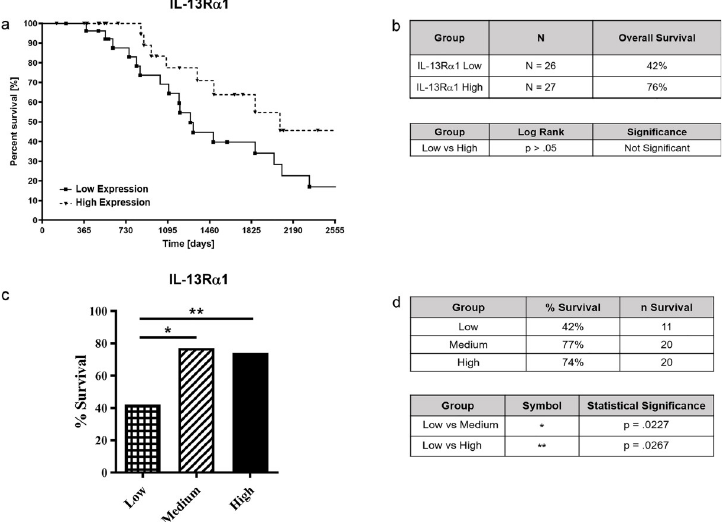
5B). In contrast with IL-13Ra2 gene expression, subjects with low expression of IL-13R α 1 had a 42% survival rate whereas subjects with medium and high IL-13R α 1 expression had a 77% and 74% survival rate, respectively (Fig 5C and 5D). Using the Fisher’s Exact Test, there was a